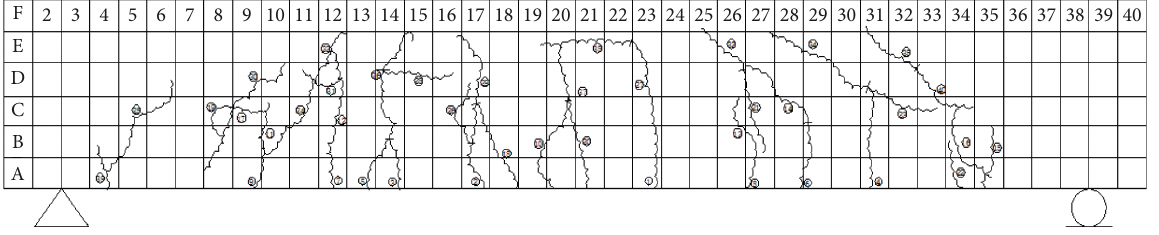
Figure 16: Crack distribution of the test beam.